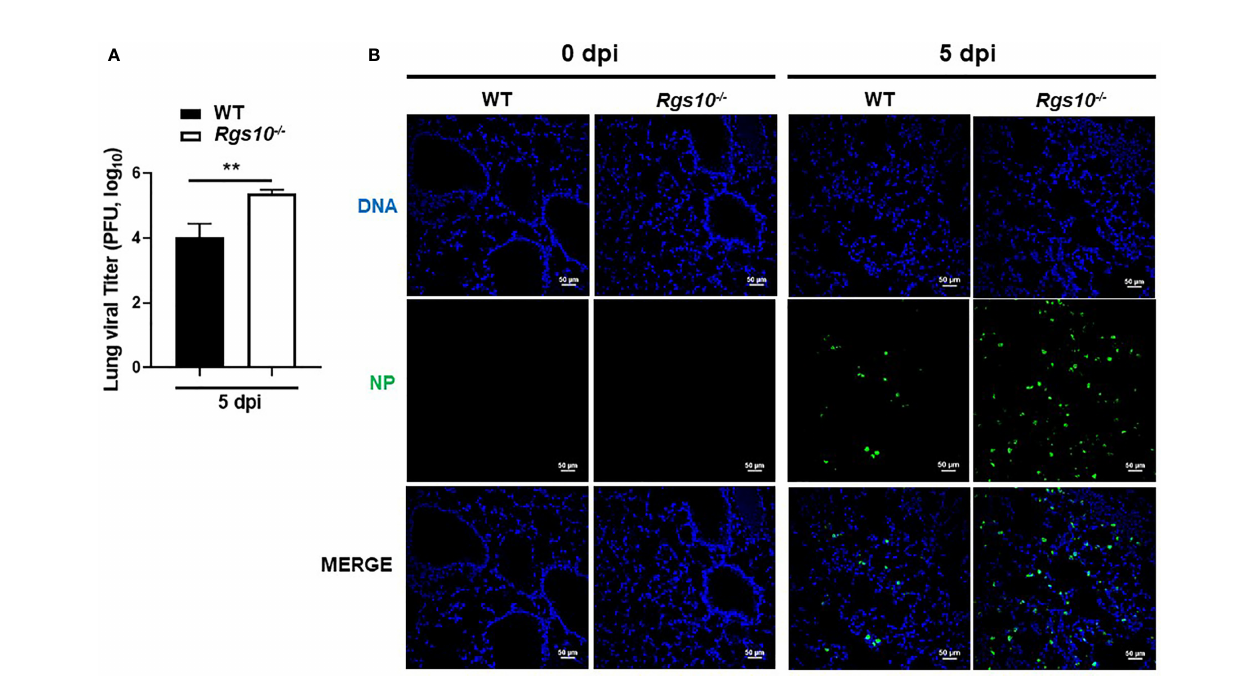
FIGURE 3 | Rgs10 de fi ciency increases viral titers in IAV-infected lungs. (A) WT and Rgs10-/- mice (n=6) were inoculated intranasally with 100 PFU of PR8 virus. Lungs were harvested from infected strains, and homogenates were prepared for viral titer assay. Comparison of lung viral loads between stains on 5 dpi were determined using plaque assay. (B) WT and Rgs10-/- mice (n=6) were infected intranasally with 100 PFU of PR8 virus as in (A) . Lungs were fi xed, and immuno fl uorescence staining was performed on infected lung sections using an anti-nucleoprotein (NP) antibody identifying in fl uenza A virus NP (green) and DAPI (blue) to detect DNA. Representative images (scale bar=50 m m) of at least fi ve similar results are shown. Data were analyzed for statistical differences using unpaired t-test between groups. Data are presented as mean ± SEM **p <